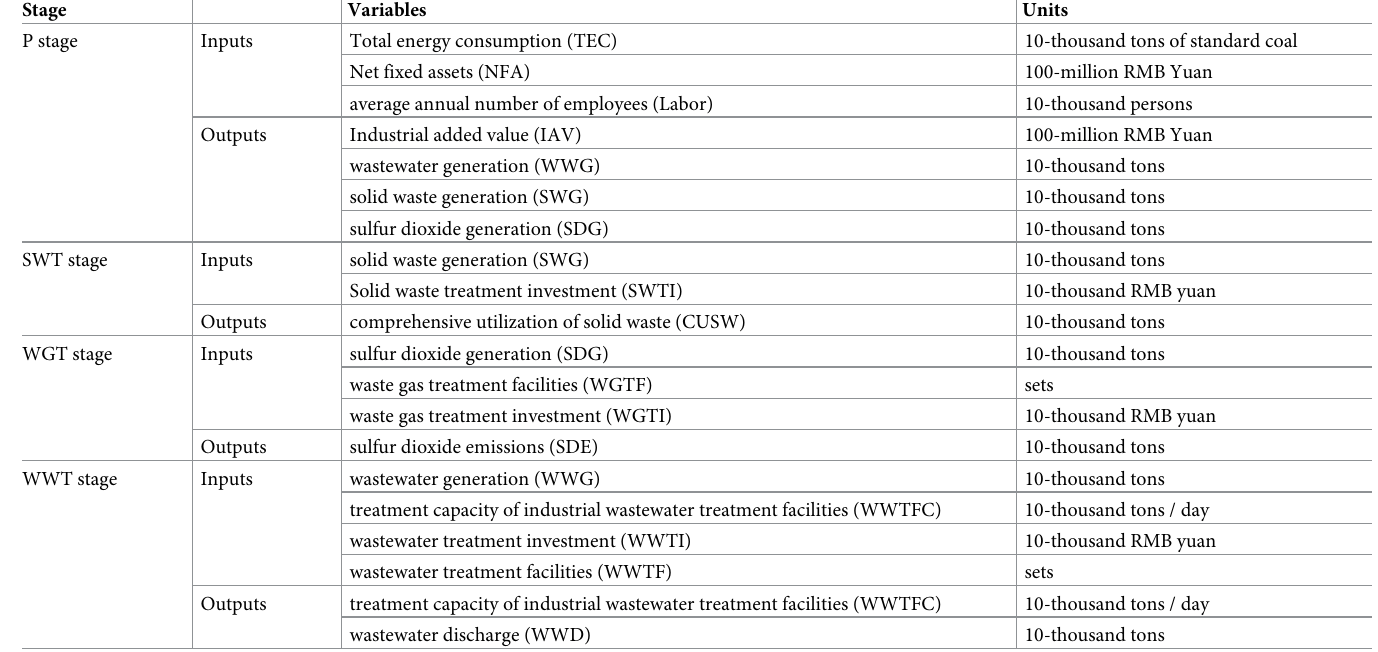
Table 1. Input-output